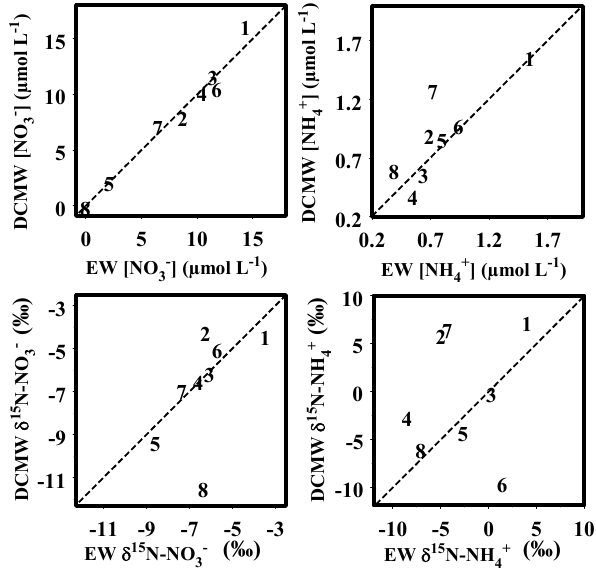
Fig. 2. Relationships between epilimnetic water (EW) and deep chlorophyll maximum water (DCMW) in terms of nitrate and am- monium concentrations and δ 15 N, from the eight Pyrenean lakes studied (lakes numbered according to Table